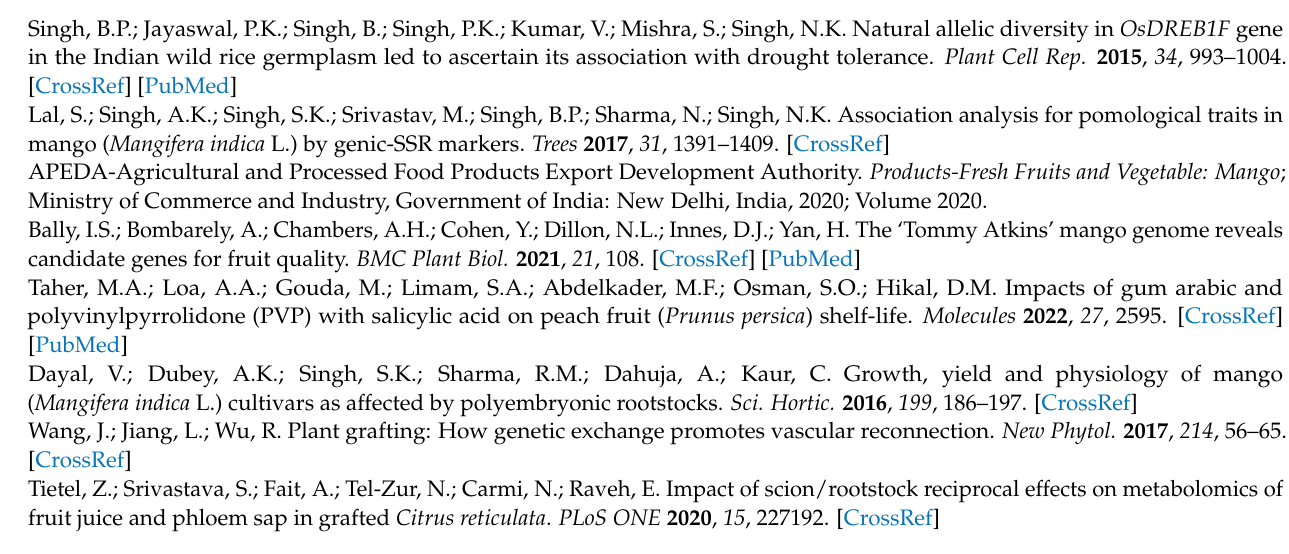
Figure S2: Molecular profiling of five mango varieties grafted on three polyembryonic rootstocks using shelf-life specific simple sequence repeat locus NMSLC-14; Figure S3: Model based population structure plot for each variety with K = 2, using Structure with 24 SSR markers. Color codes are as follows: Population A red, Population B green, population. Delta K vs KEvanno plot showing K = 2 having the peak delta K value, suggesting existence of two sub-populations in 15 scion/rootstock combinations; Figure S4: Quantile–quantile (QQ) plots showing the distribution of observed verses expected p values. Significant associations were observed for fruit weight, yield efficiency, peel thickness, pulp percent, total soluble solids and acidity; Figure S5: Mapchart indicating the position and relative distance of the tested markers on different mango chromosomes; Table S1: Description of five mango varieties grafted on three polyembryonic rootstocks; Table S2: List of primer sequences, annealing temperature and product size of shelf-life specific primers used in five mango varieties grafted on three polyembryonic rootstocks; Table S3: Distribution of five mango varieties grafted on three polyembryonic rootstocks in different clusters using shelf-life specific